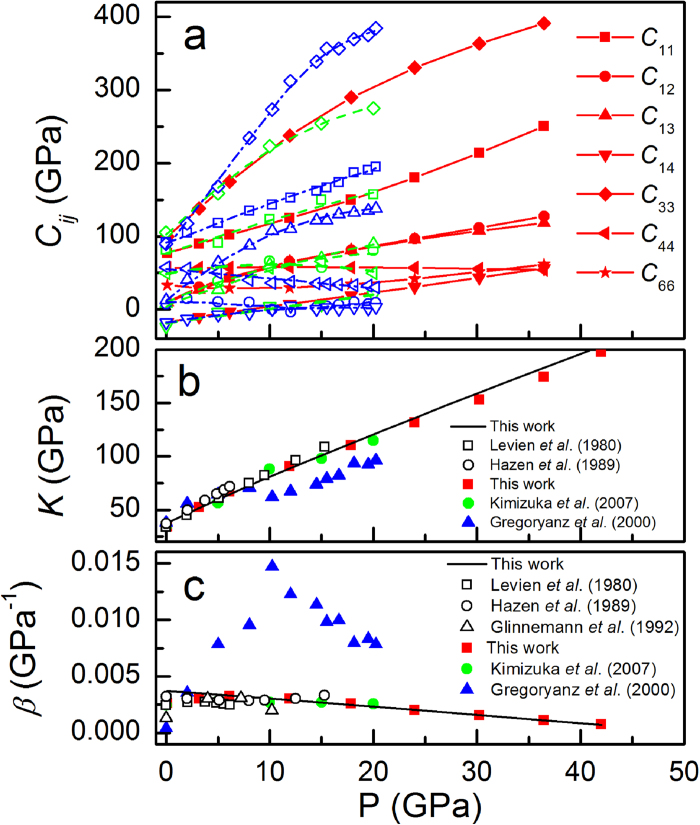
Elastic properties of α-quartz at high pressures.(a) Individual elastic constants, (b) bulk modulus, and (c) the anisotropy of linear compressibility of α-quartz SiO2 as a function of pressure. In (a) the solid-curve penetrated symbols represent this work, the dash-curve penetrated symbols LDA calculation28, and the dot-dash-curve penetrated symbols Brillouin scattering experiment5. In (b) and (c) the solid squares, solid circles28, and solid triangles5 are calculated from elastic moduli. The solid lines, open squares43, open circles15, and open triangles44 are calculated from the volumetric and axial compressibility data.